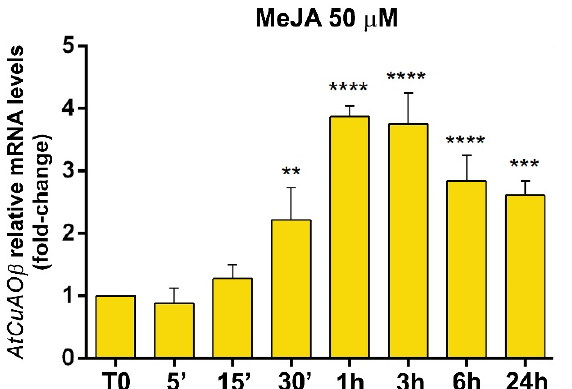
Figure 2. Time course analysis of AtCuAO β gene expression by RT-qPCR after 50 µ M MeJA treatment. Gene expression was analysed in seven-day-old WT seedlings untreated or treated for 0 h